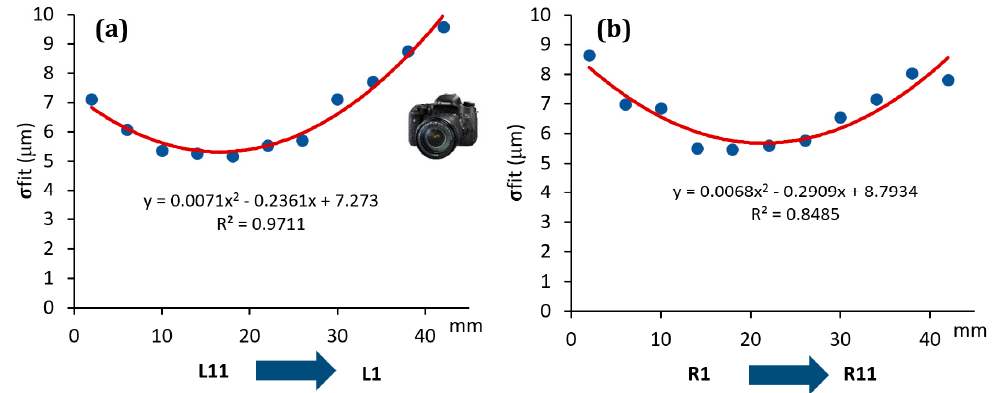
Figure 8. Trend of the sigma fitting error ( σ fit) evaluated considering the distance from the sensor for PSSRT scanner. Left groove sides ( a ) and right groove sides ( b ).